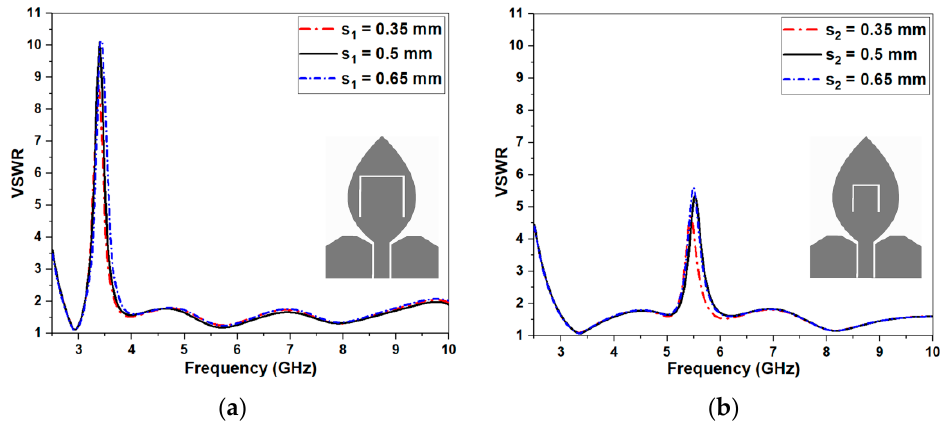
Figure 3. Simulated VSWR with different lengths of the loaded slot: ( a ) external half-square-like slot; ( b ) inner half-square-like slot.